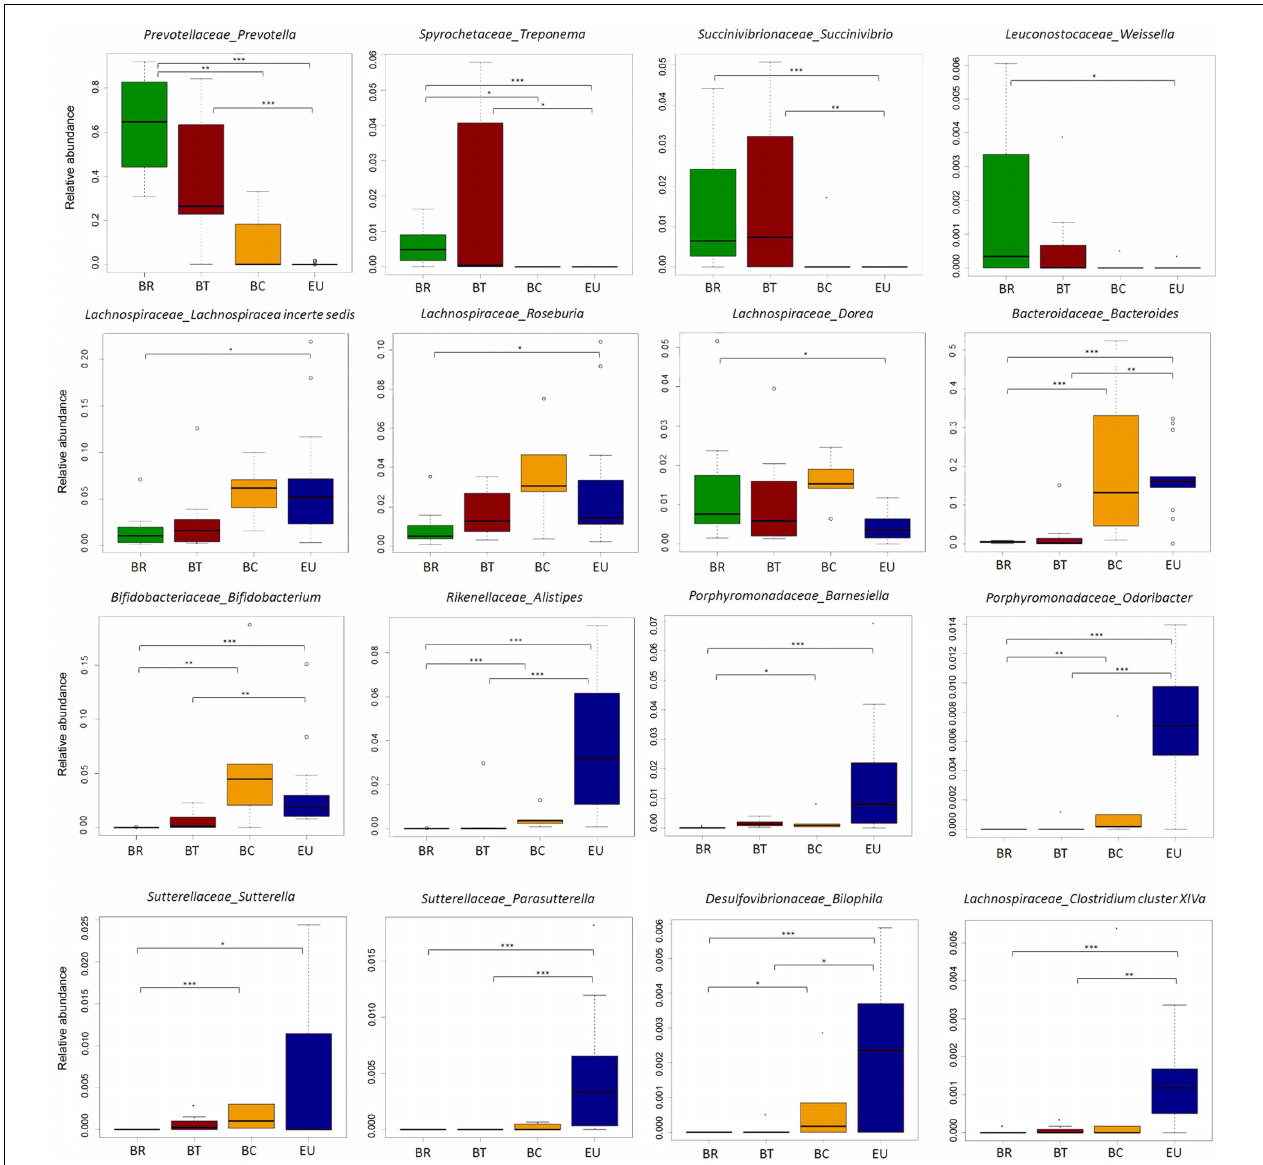
FIGURE 6 | Disappearance of ancient microbial pattern and acquisition of “Western” microbial profiles passing from rural to urban environments in Burkina Faso populations. Box plot of relative abundances of the statistically significant different genera in African groups in comparison with European population (Wilcoxon pairwise test; ∗ p -value < 0.05, ∗∗ p -value < 0.01, ∗∗∗ p -value <